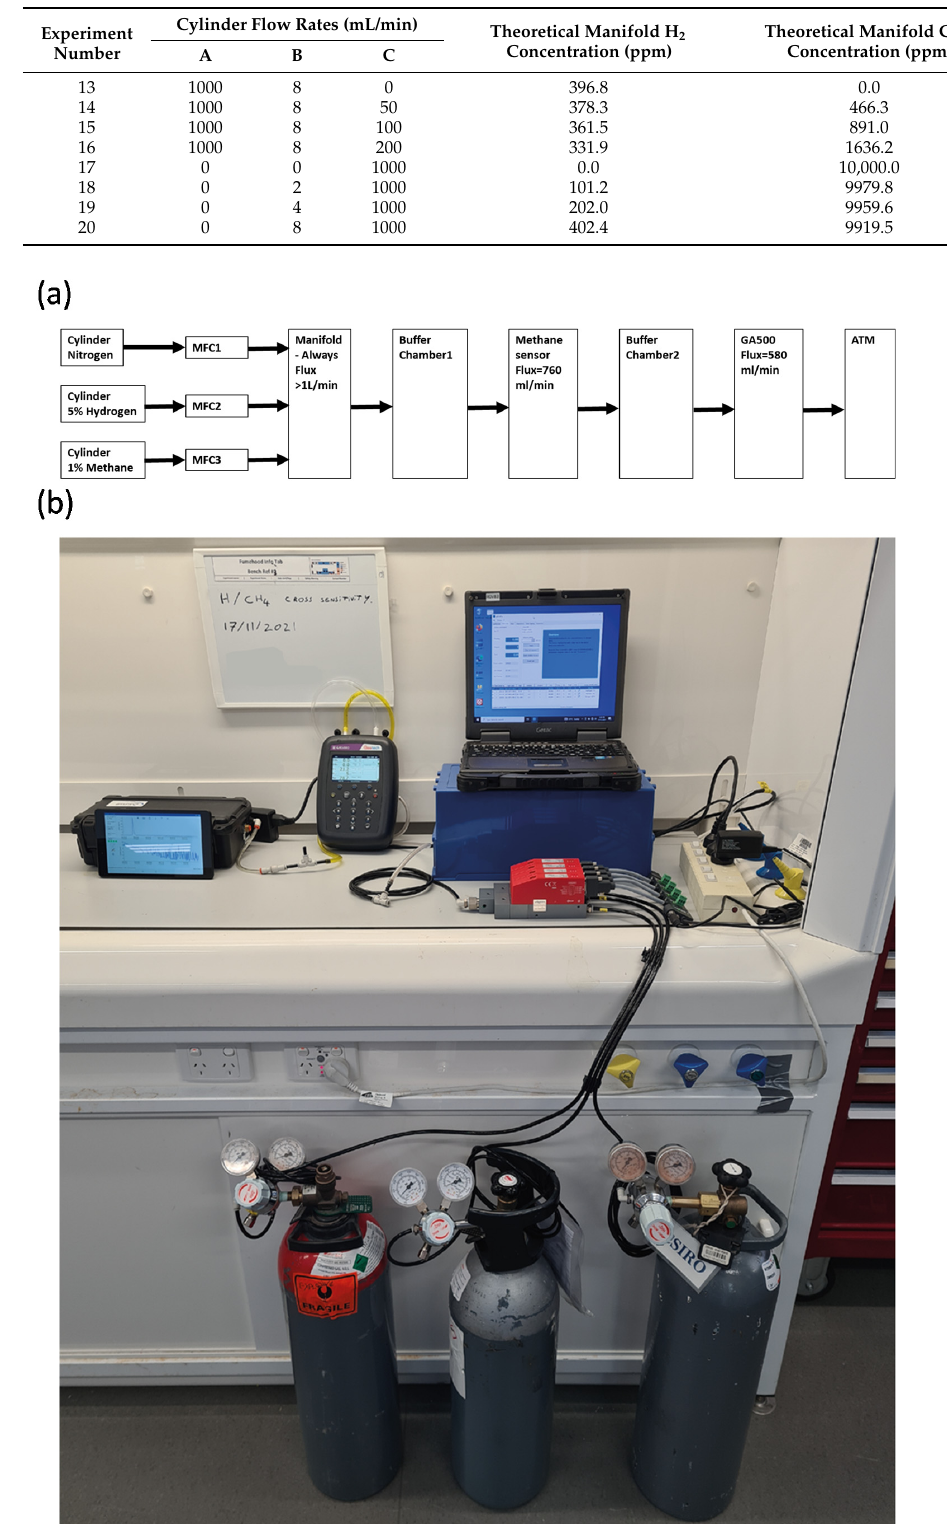
Figure 2. ( a ) Experimental setup flow diagram showing different components of the setup and ( b ) photograph of the setup including: cylinders (bottom), mass flow controller in red, computer to control the mass flow controller, GA5000 (middle left), and methane sensor (far left).